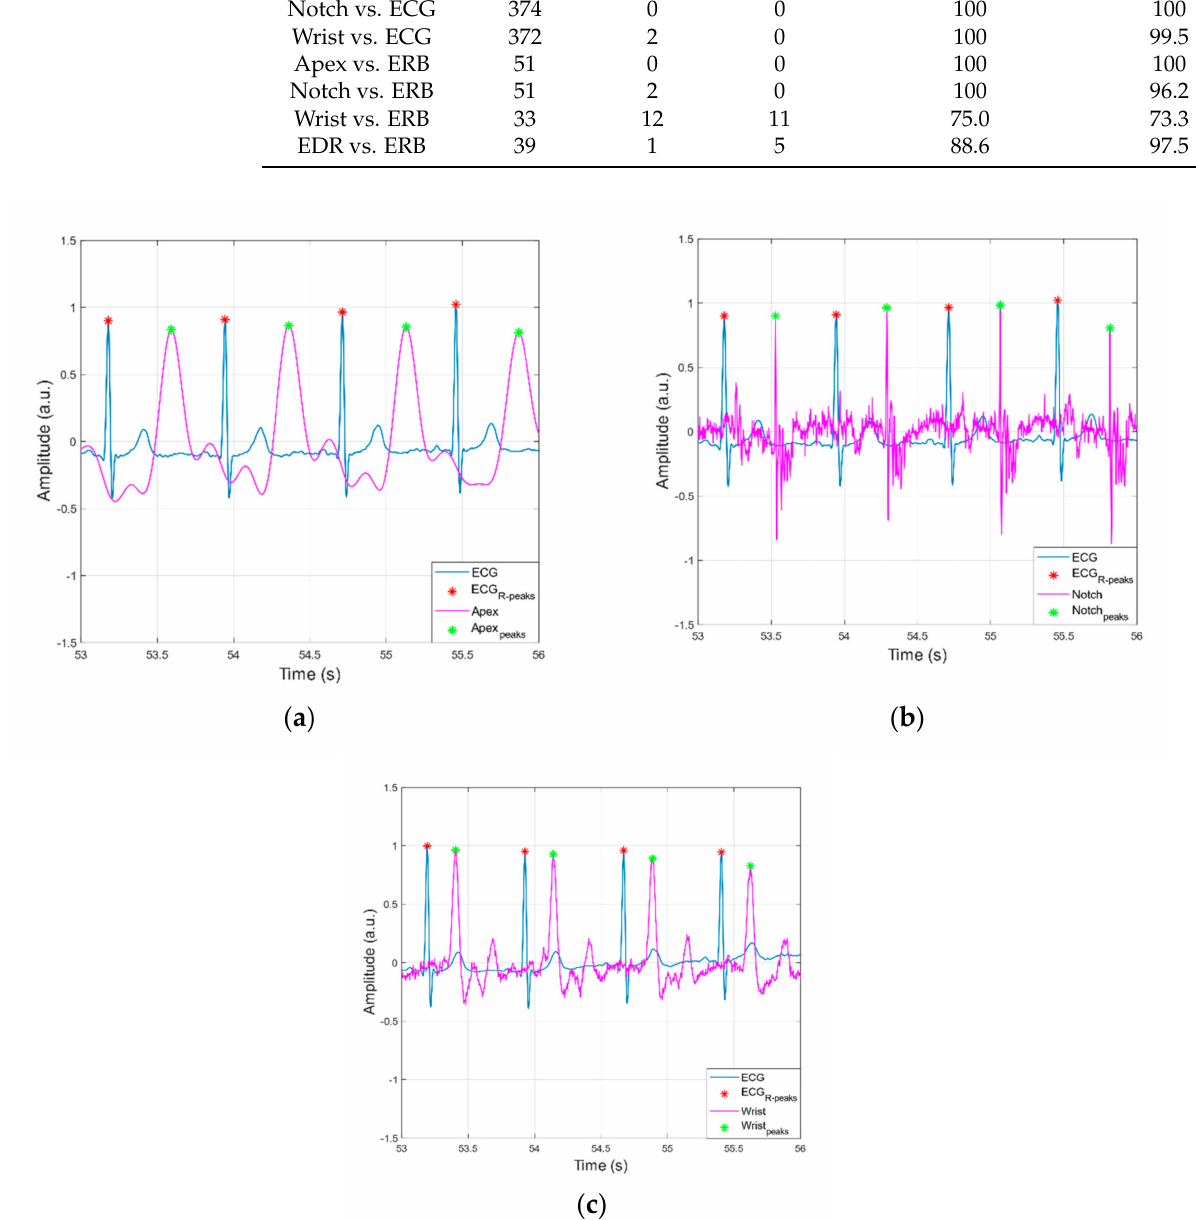
Figure 9. Examples of peaks detection in ECG versus heart monitoring signals acquired via the proposed sensor from: ( a ) heart apex; ( b ) suprasternal notch; ( c )